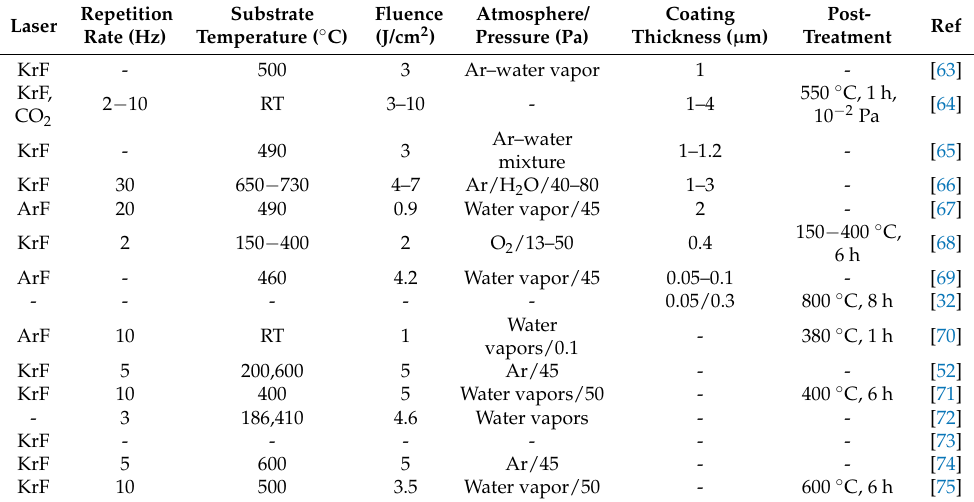
Table 1. Pulsed laser deposition (PLD) experimental details given in the papers considered in this review, in the chronological order in which they were reported in the